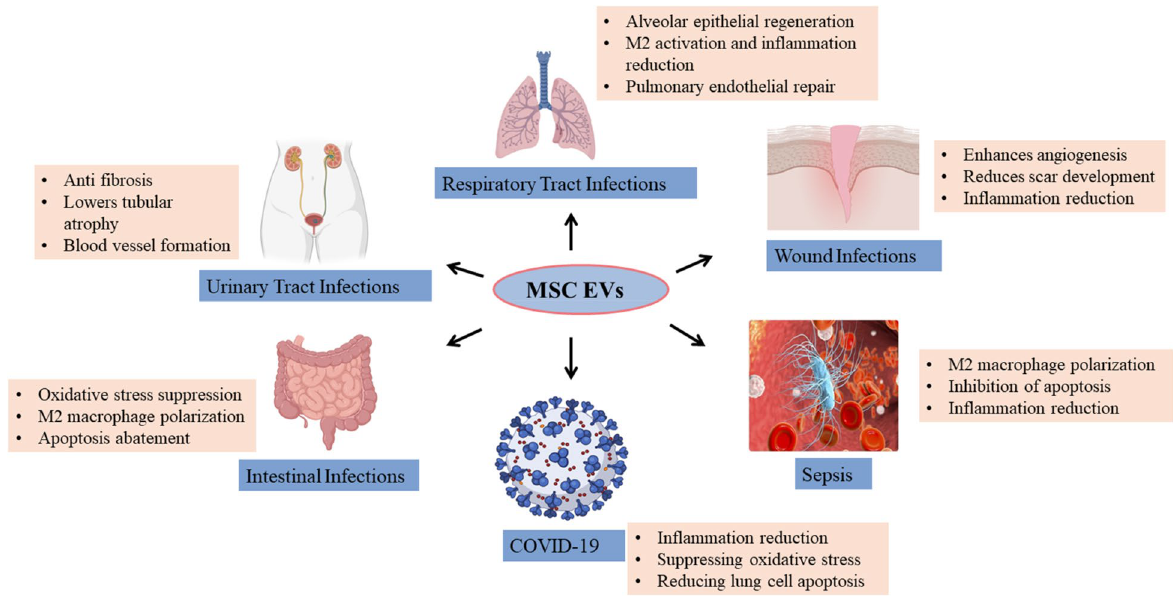
Fig. 2 Potential therapeutic role of MSC-EVs in infectious